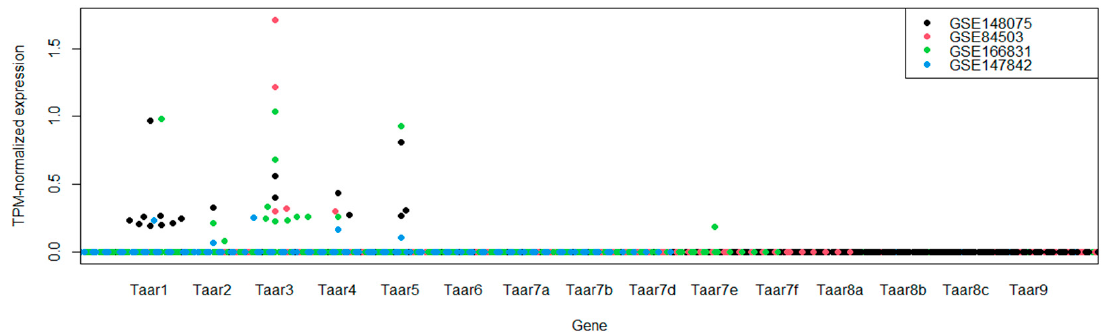
Figure 2. Expression levels of TAARs in whole-tissue mouse hippocampal samples represented in the GEO database.